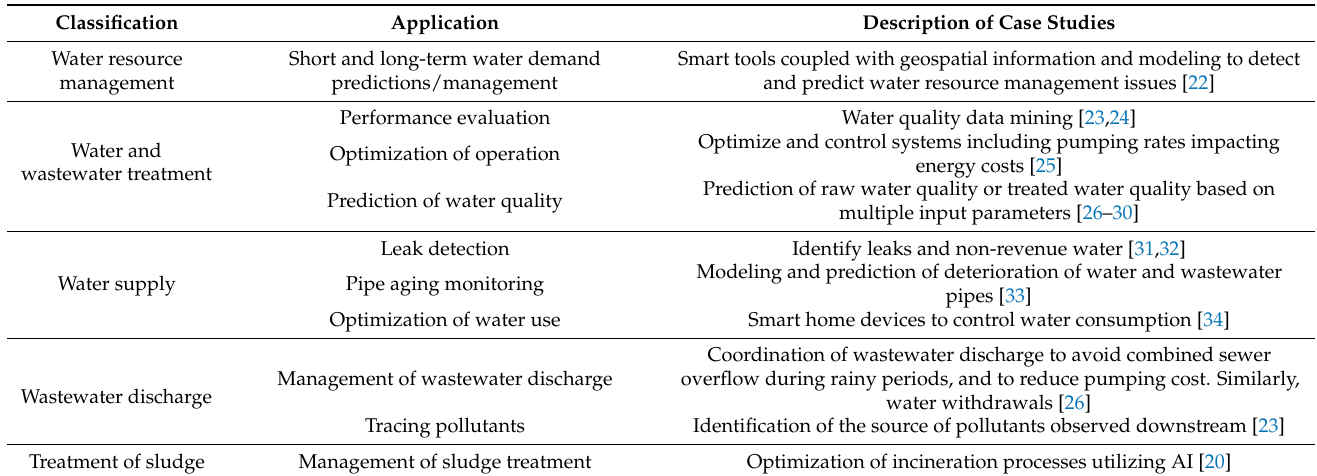
Table 2. Key existing and potential applications of AI in water supply and wastewater management.